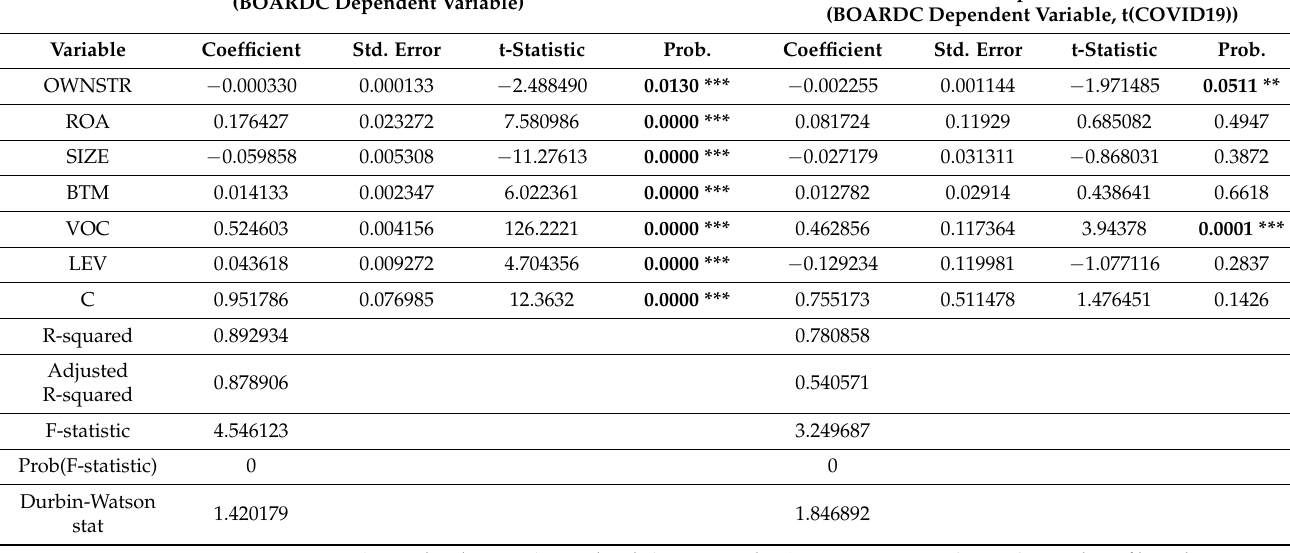
Table 5. The influence of voter ownership concentration on the quality of board composition. Panel A Focus on Voter Ownership with Quality Board